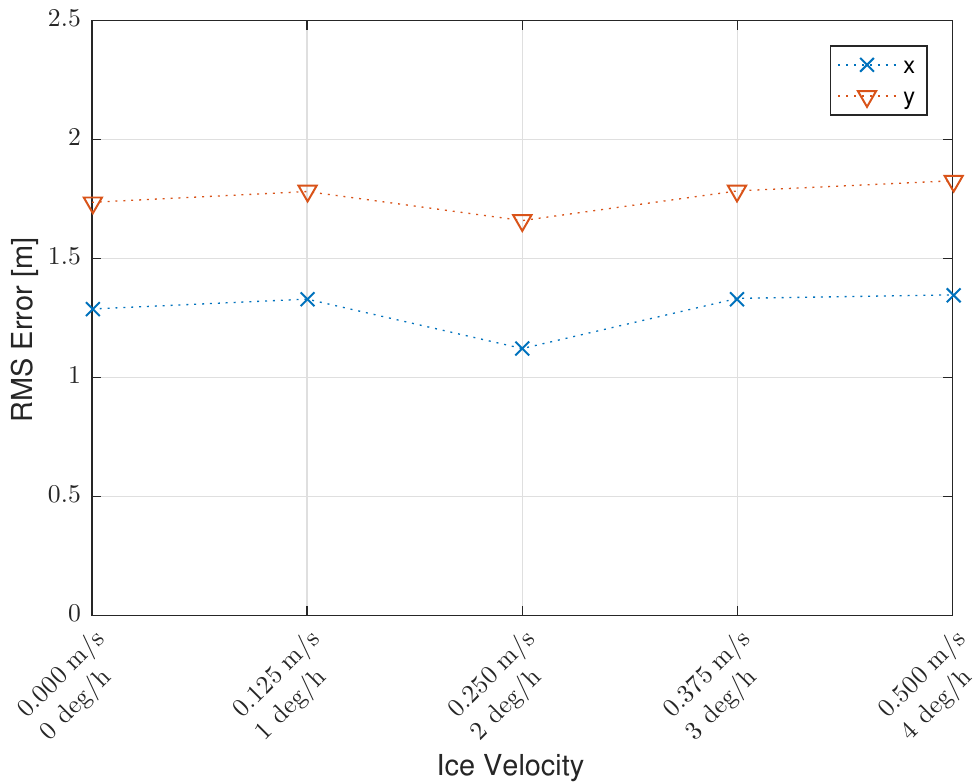
Figure 5. Ice-relative vehicle x − y position RMS error averaged over each simulated mission, shown as a function of simulated ice floe velocity. A 500 m GNSS line configuration and 40 m OWTT beacon spacing are assumed. The the 0.25 m/s, 2 ◦ /h simulation is an outlier to the otherwise slightly